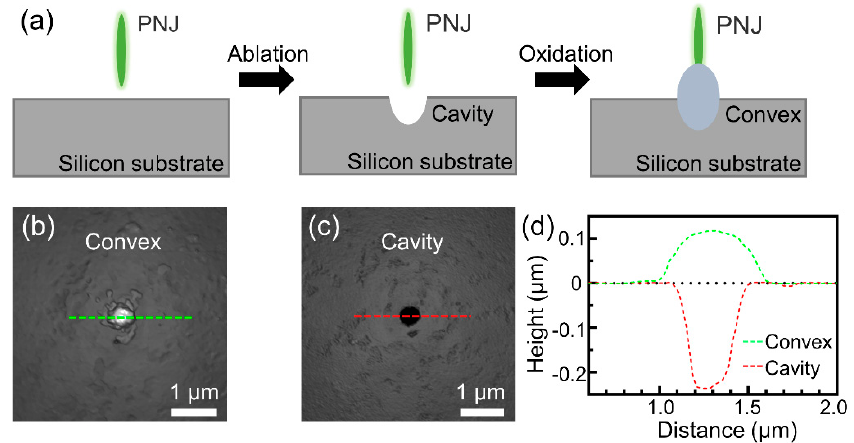
Figure 3. ( a ) Oxidation of the silicon substrate by the PNJ. ( b ) AFM image of convex silicon oxide induced by the PNJ. ( c ) AFM image showing the cavity etched from silicon oxide on silicon with 10% HF. ( d ) Cross-sectional views of the dotted lines in ( b , c ).